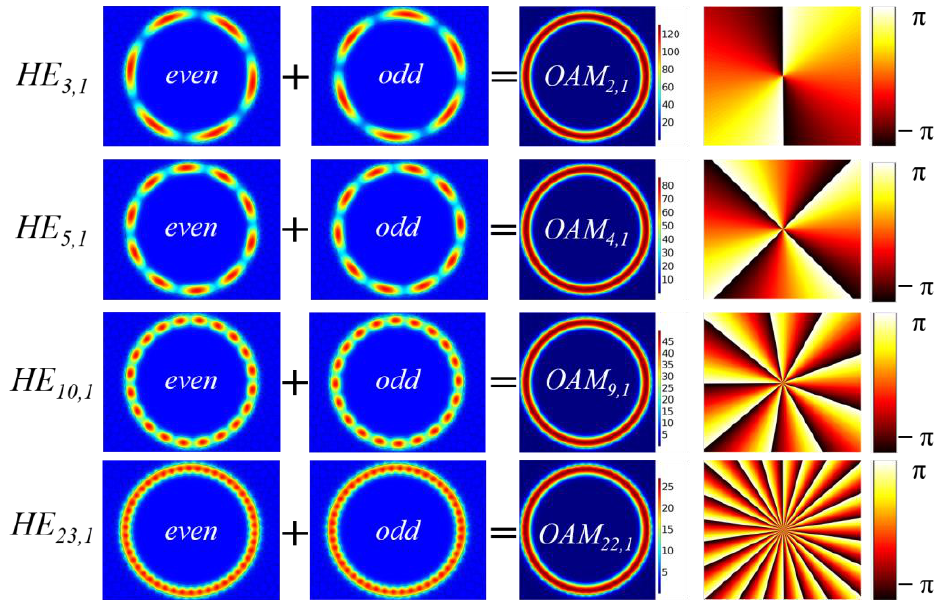
Figure 5. OAM 2,1 , OAM 4,1 , OAM 9,1 , OAM 22,1 mode generation process and corresponding wavefront phase distribution diagram. phase distribution